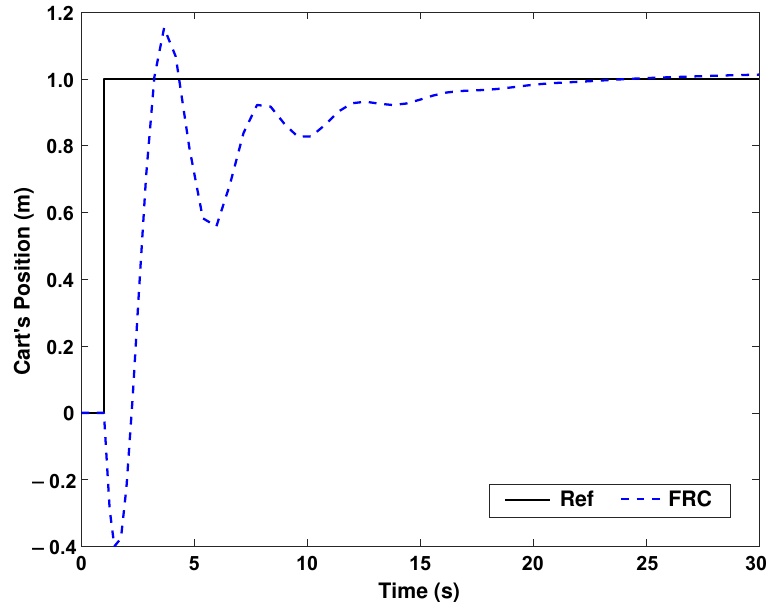
Figure 3. Position control of cart by